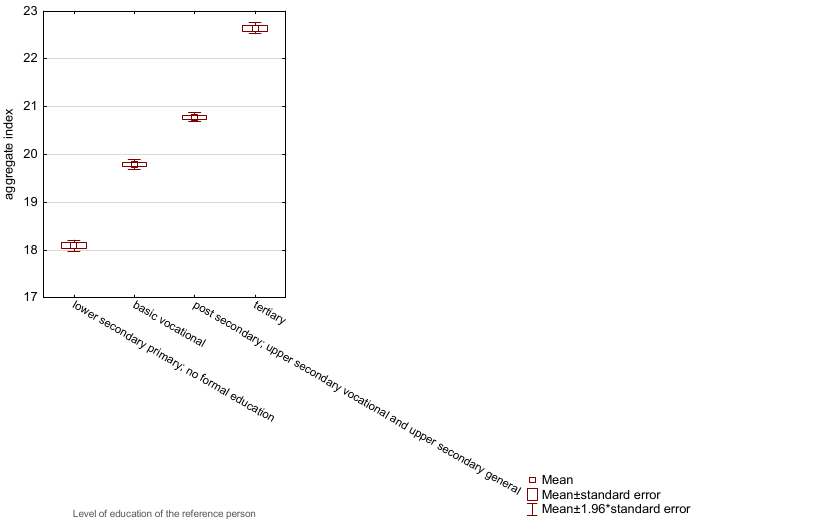
Figure 9. The level of the aggregate indicator in 2018 according to the education level of the person representing the household of people aged 60 and older. Source: own elaboration based on data from [136].